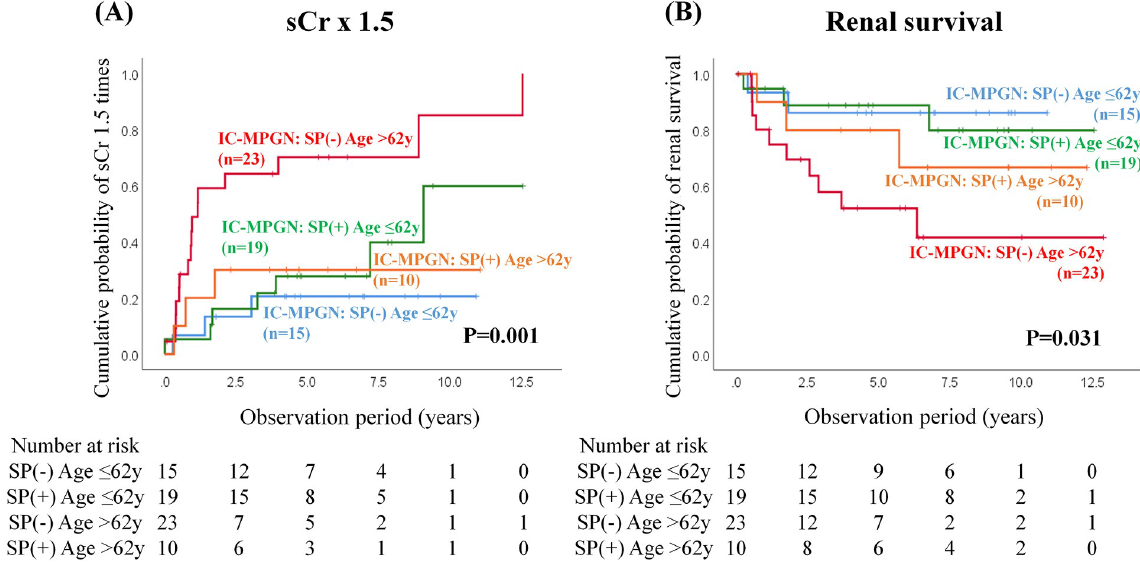
Fig 3. Renal outcomes of IC-MPGN patients with or without steroid pulse therapy stratified by median age (62 y) at onset in serum creatinine elevations of 50% (sCr × 1.5, A) and end-stage kidney disease (B). Kaplan-Meier curves for treated and untreated patients analyzed using log-rank tests. IC-MPGN, immune-complex membranoproliferative glomerulonephritis; SP, steroid pulse.